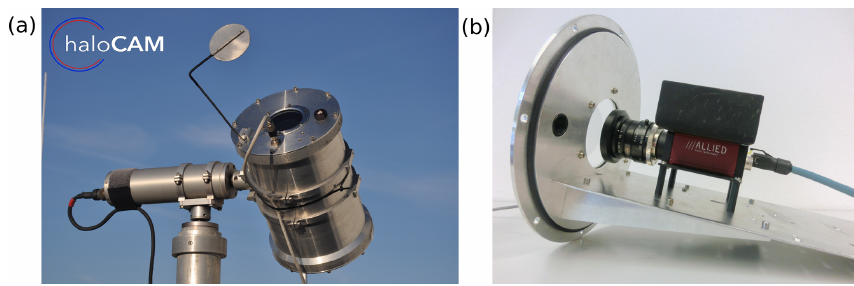
Figure 1. (a) HaloCam setup with HaloCam RAW . The circular shade blocks direct sunlight and is covered with black, antireflective color on the side facing the camera. (b) Interior of HaloCam RAW ’s weather-proof casing. HaloCam RAW consists of an Allied Vision Manta G-235C camera with a Kowa lens of 6mm focal length. The camera is fixed on a “drawer”, which is attached to the circular front lid of the cylindric weather-proof casing. A metal sheet is glued on the top of the camera body with a thermal compound to support the cooling of the camera. For the window of the camera casing, a Heliopan UV filter with antireflection coating was used. The PoE (Power over Ethernet) cable is guided inside the camera casing via a water-proof connecting plug through the lid just below the window.